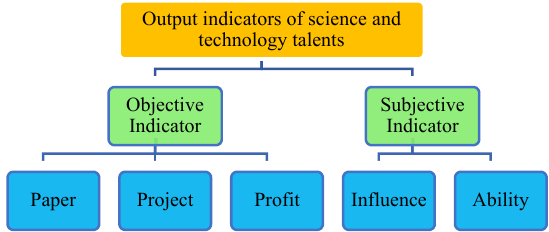
Figure 2. Output indicators of science and technology talents.